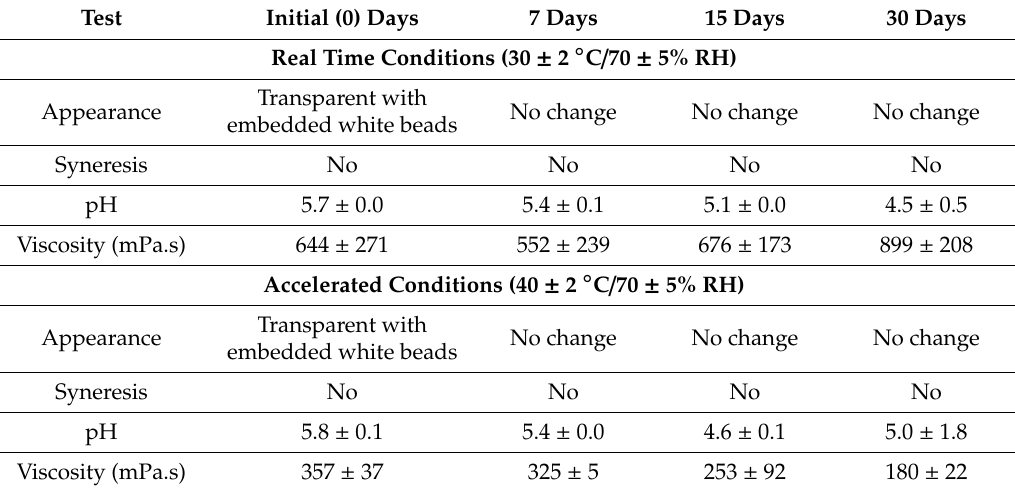
Table 3. Stability study of CBZ